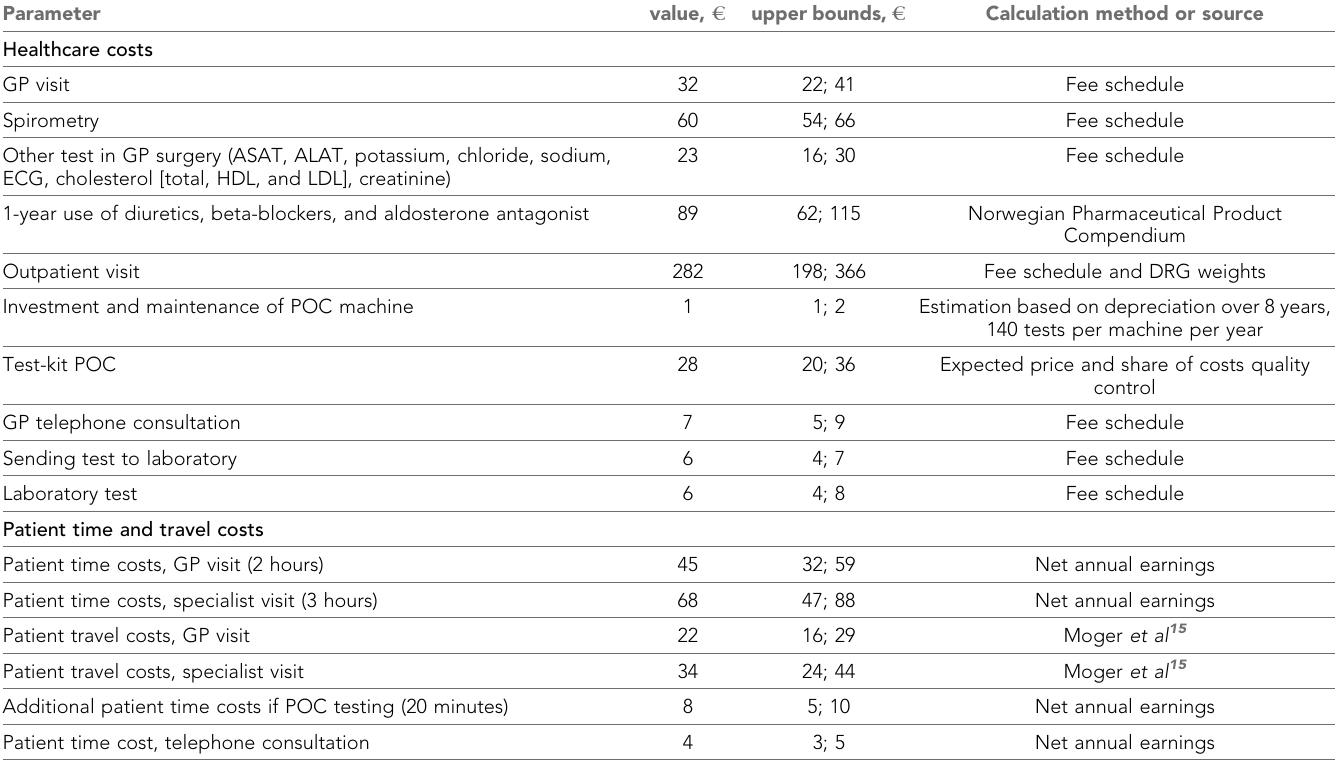
Table 2. Model costs ( e 1.00 [2017 Euro] = NOK 9.00)